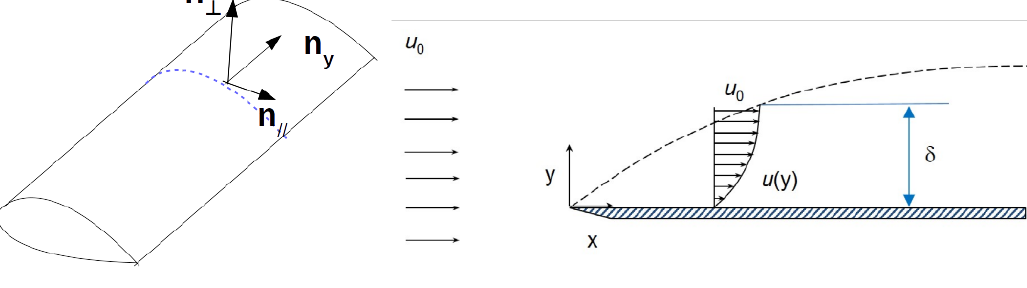
Figure 17. left : Illustration of coordinate system used to post-process shape factor; right : schematics of boundary layer over a flat